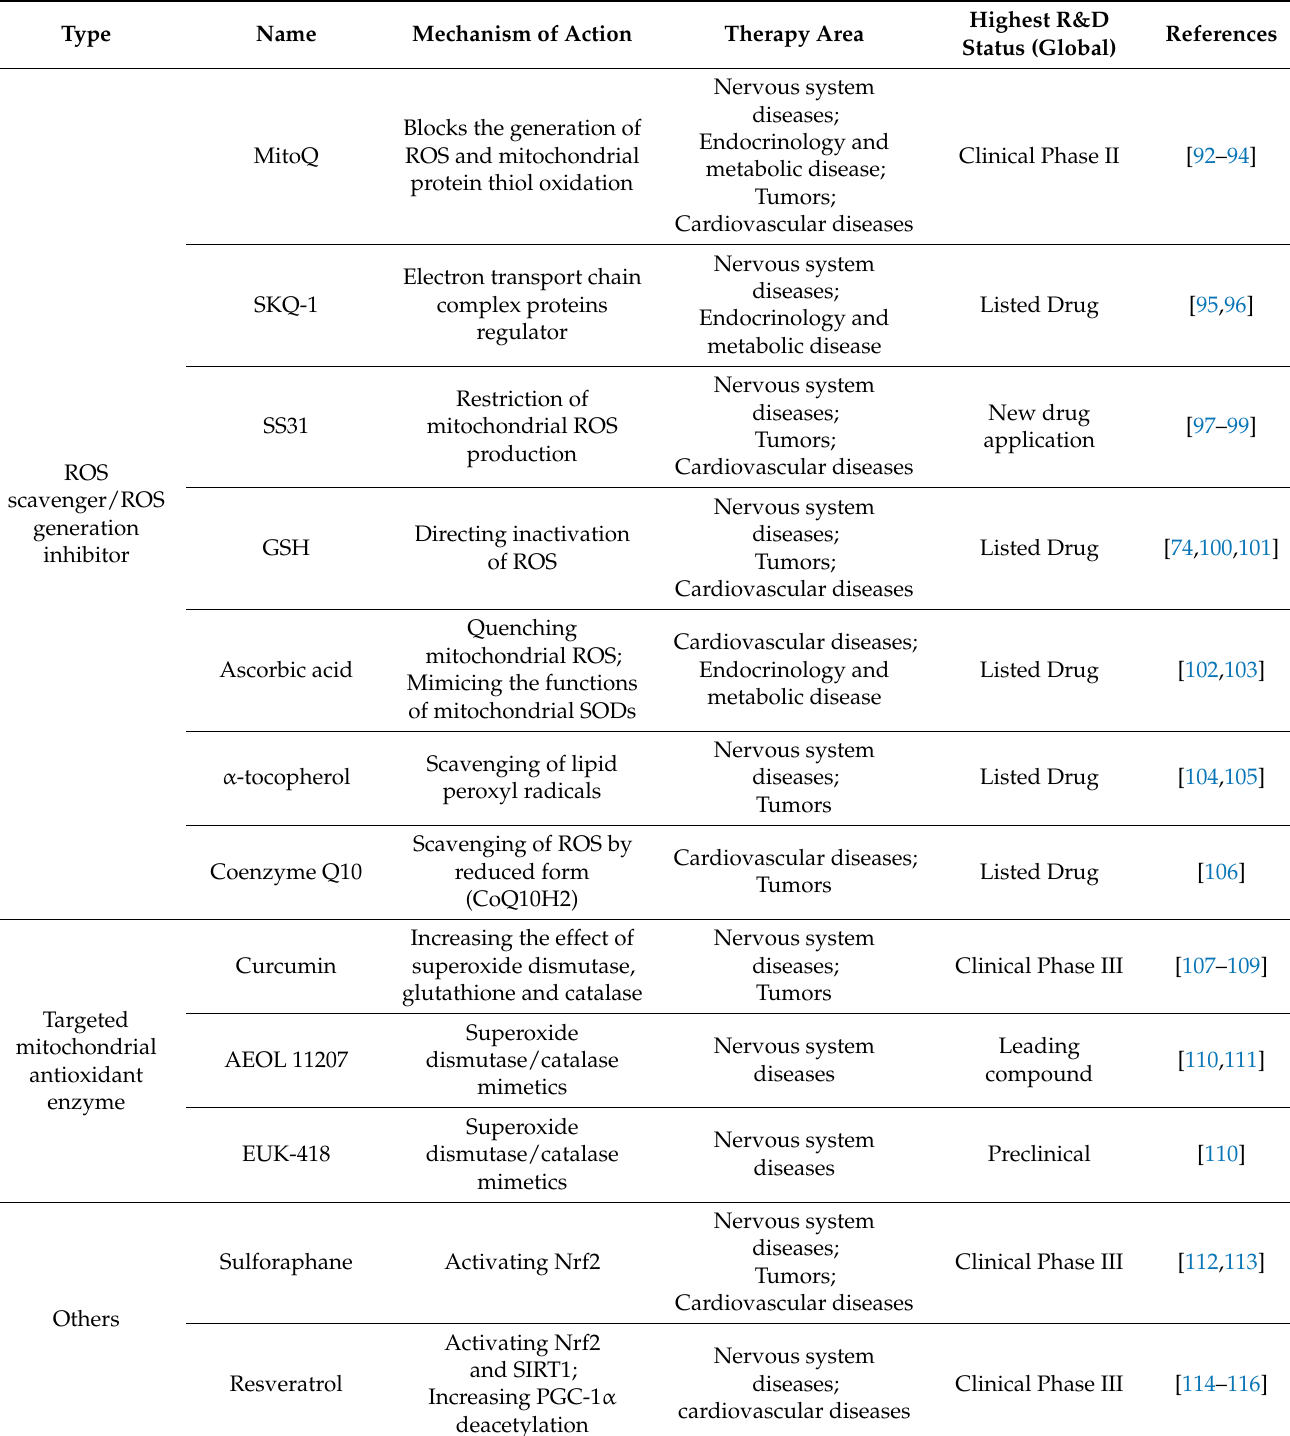
Table 2. Antioxidants targeting mitochondrial oxidative